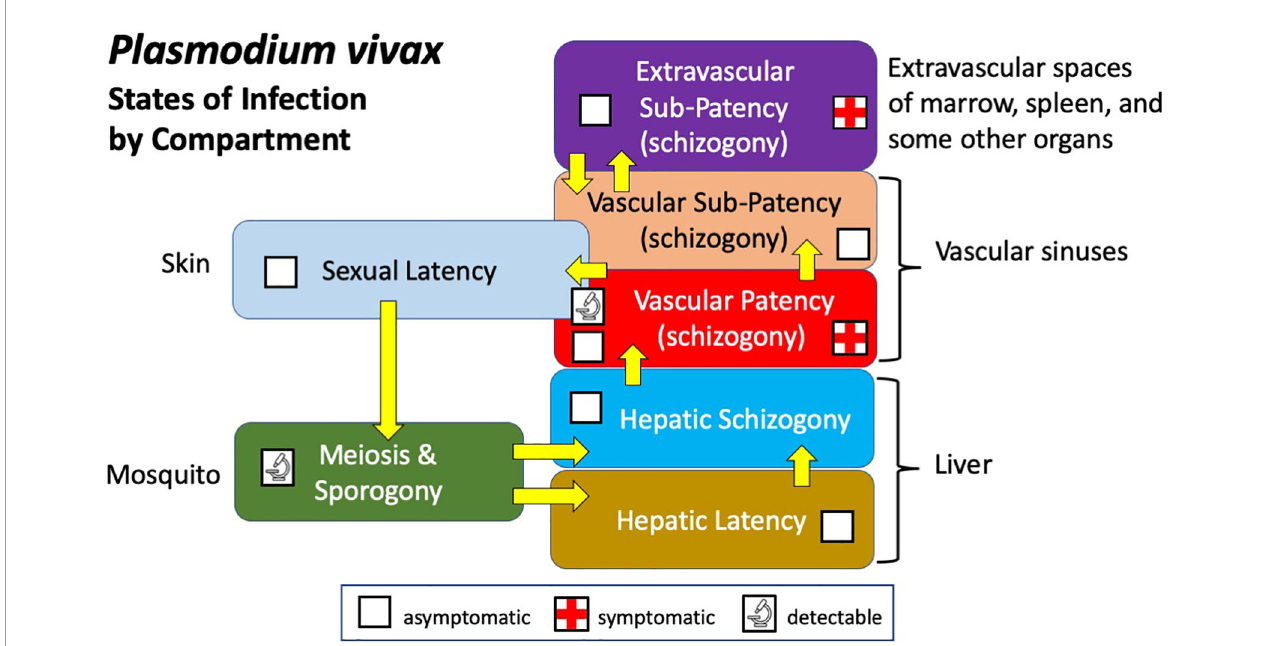
FIGURE 1 | Diagram illustrating the states and compartments of infection by P. vivax in humans and